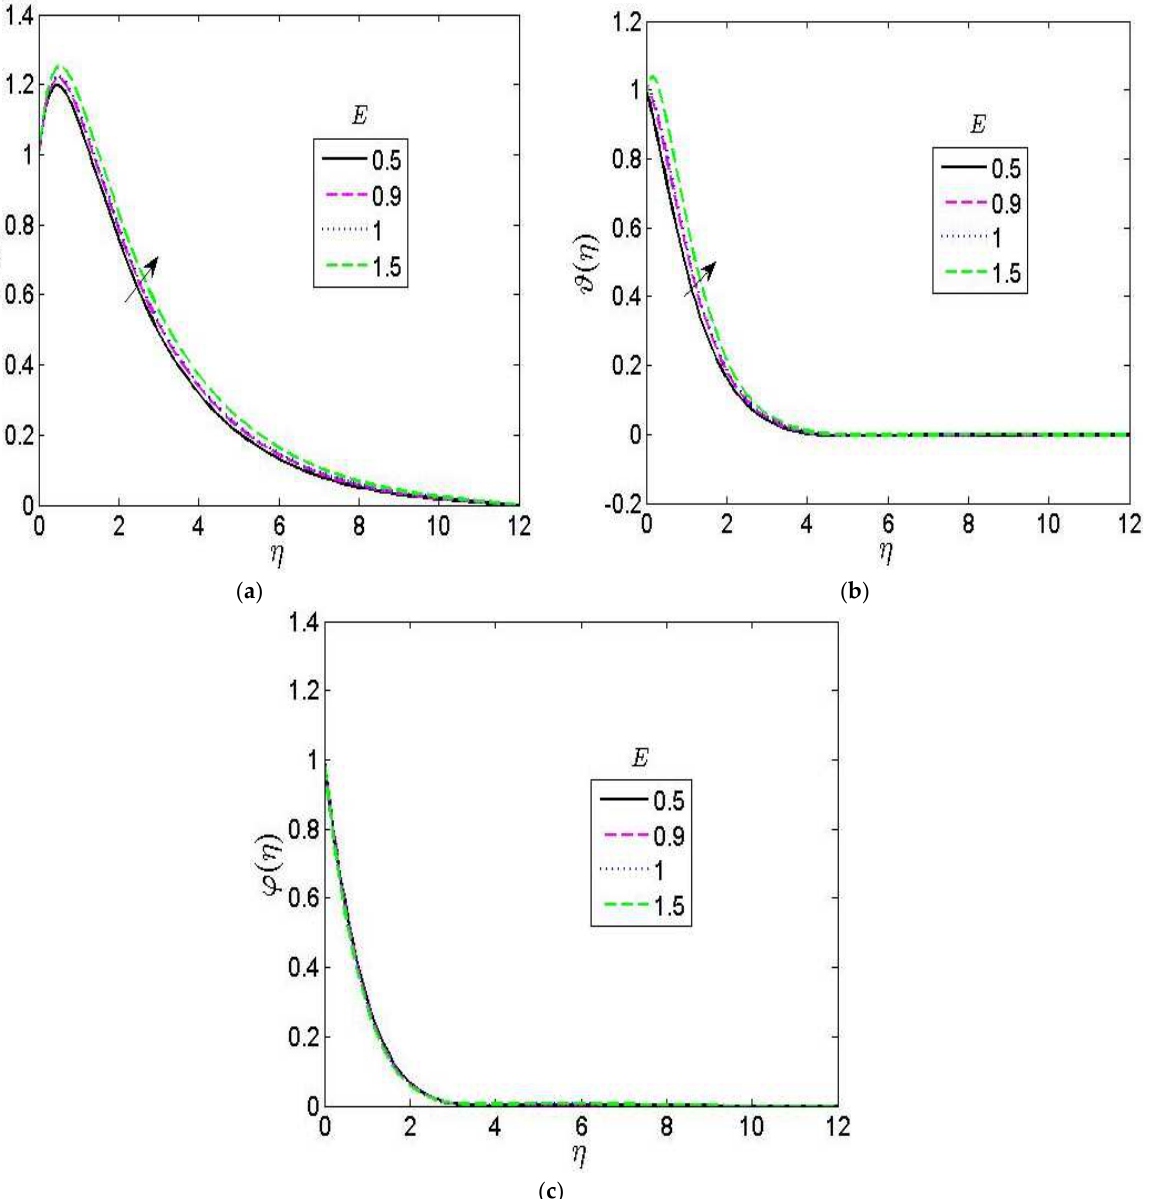
Figure 5. Effect of Eckert number E on ( a ) velocity, ( b ) temperature, and ( c ) concentration profiles. Figure 6 exhibits the velocity, concentration, and temperature plots for distinct num- bers of Schmidt (Sc). Sc defined the quotient of momentum over mass diffusivity. Thus, in Figure 6c, a decrease in the concentration distribution is observed when Sc is increased. In fact, it shows that larger values of Sc are equivalent to very small mass diffusivity. In Figure 6a, a degeneration in the fluid velocity is noted when Sc is increased.